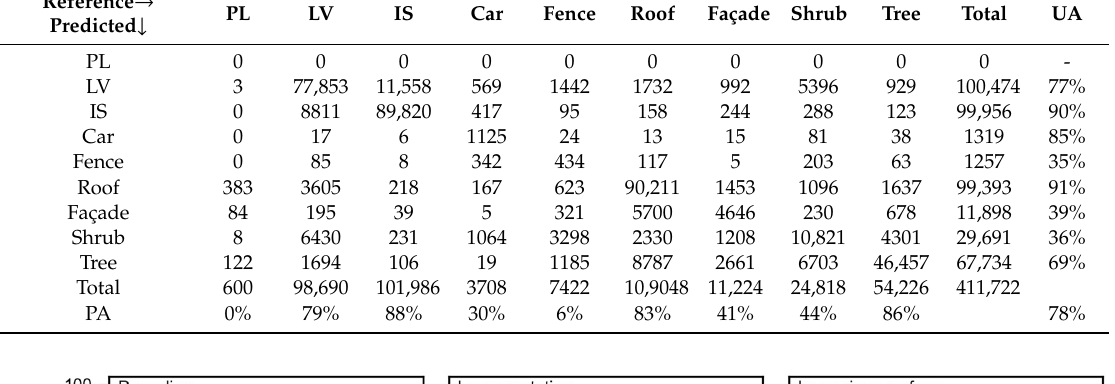
Table 2. Confusion matrix between the reference and the predict of the proposed method (RF+GMM as an example). UA is user accuracy and PA is producer accuracy.